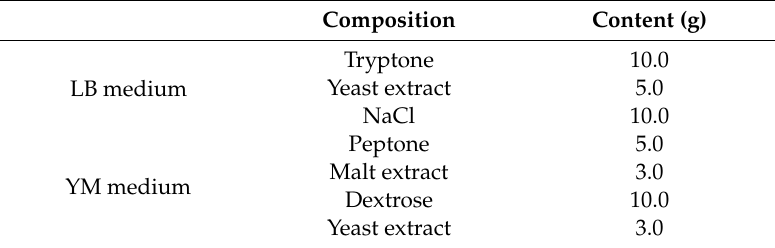
Table 1. Compositions of LB and YM growth